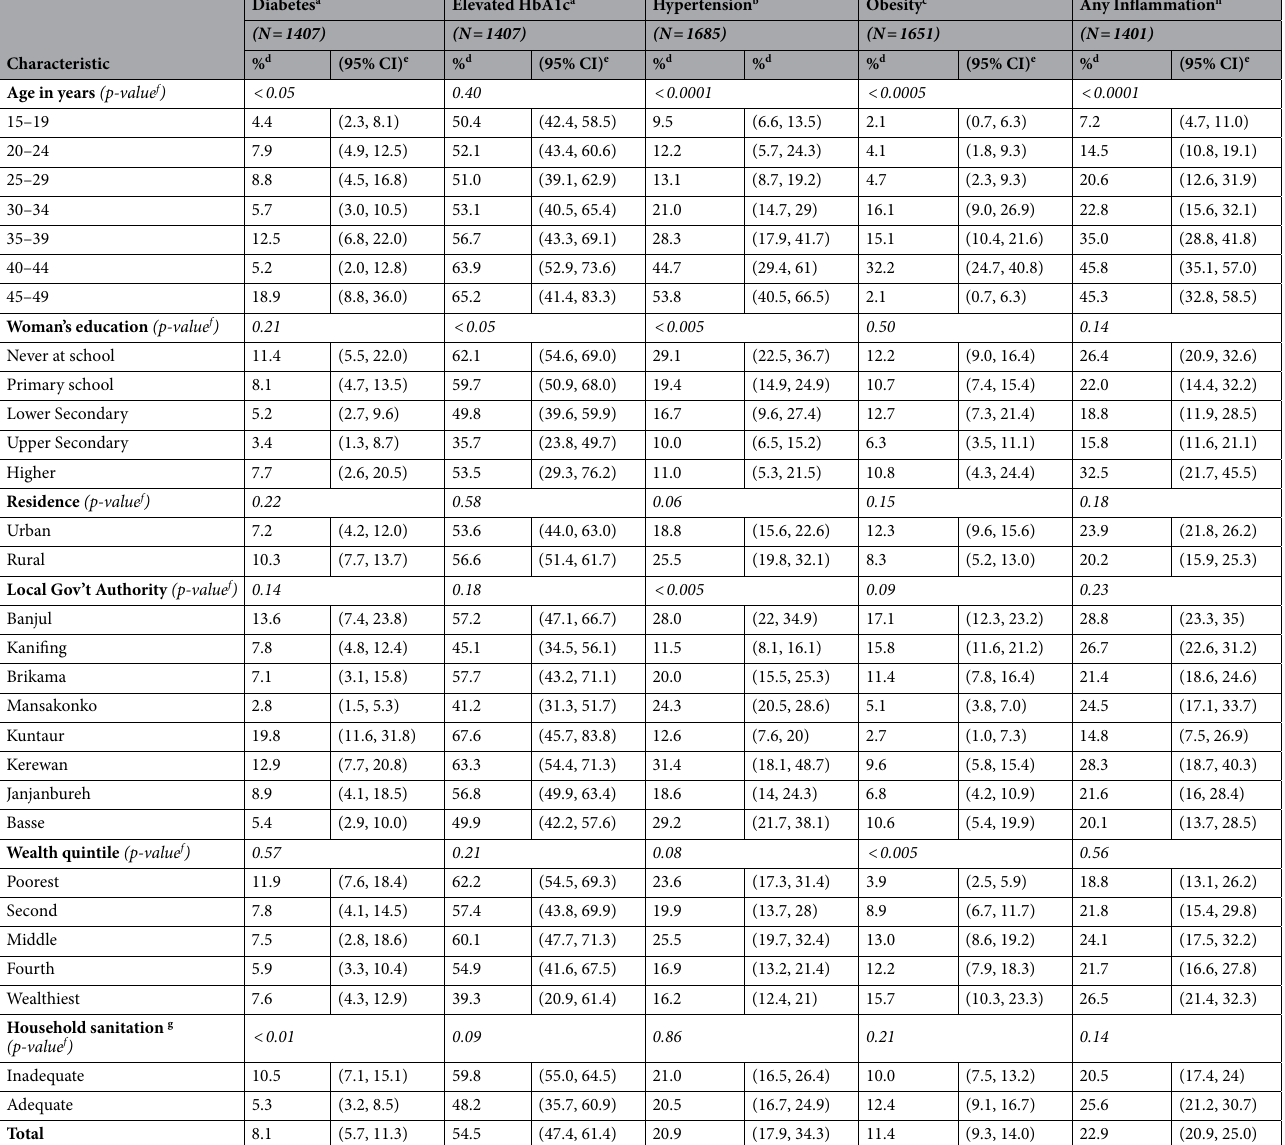
Table 1. Associations between cardio metabolic risk factors and demographic indicators in non-pregnant women, The Gambia, 2018. Note: All N’s reflect the total number of subjects with valid data for each condition. N’s for each sub-group analysis vary slightly. a Diabetes defined as glycated hemoglobin (HbA1c) ≥ 6.5% and elevated HbA1c as ≥ 5.7% b Hypertension defined as systolic blood pressure of ≥ 140 mmHg and/or a diastolic blood pressure of ≥ 90 mmHg. c Obesity defined as body mass index (BMI) of ≥ 30 kg/ m2. d Percentages weighted for non-response and survey design. e CI = confidence interval, adjusted for cluster and stratified sampling design. f Chi-square p-value < 0.05 indicates that the proportion in at least one subgroup is statistically significant. g Composite variable of toilet type and if toilet facilities are shared with non-household members; Adequate Sanitation = flush or pour flush toilet or pit latrine with slab not shared with another household; Inadequate sanitation = open pit, bucket latrine, hanging toilet/latrine, no facility, bush, field. h Any inflammation defined as CRP > 3 mg/L and/or AGP > 1